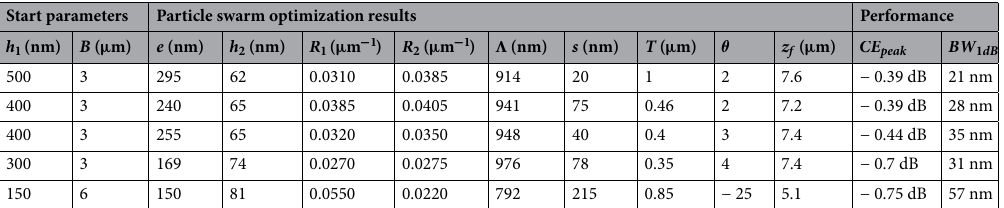
Table 2. Design parameters and numerical results of the simulated Si–Si 3 N 4 GCs for 500, 400, 300 and 150 nm thick Si 3 N 4 photonic